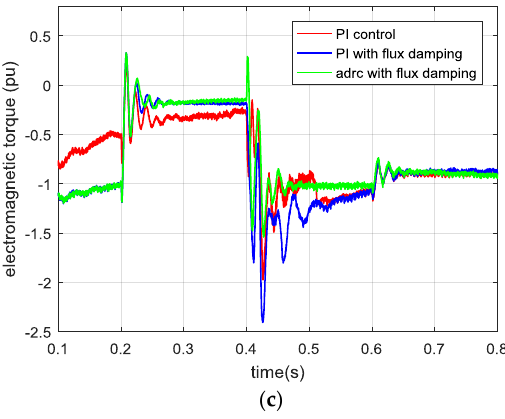
Figure 11. Symmetrical 80% voltage dip case: ( a ) DC bus voltage; ( b ) rotor current; and ( c ) electromagnetic torque.